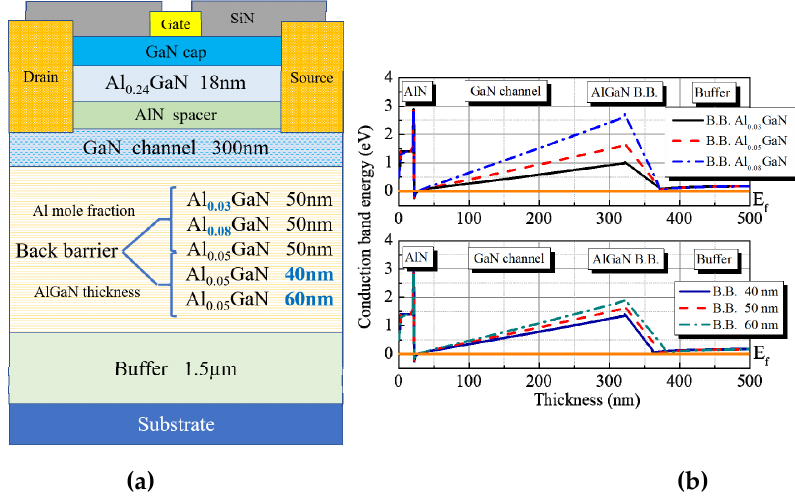
Figure 1. ( a ) Cross-section of AlGaN/GaN with AlGaN back barrier high electron mobility transistor (HEMT) on Si substrate; ( b ) 1-D poisson simulation.